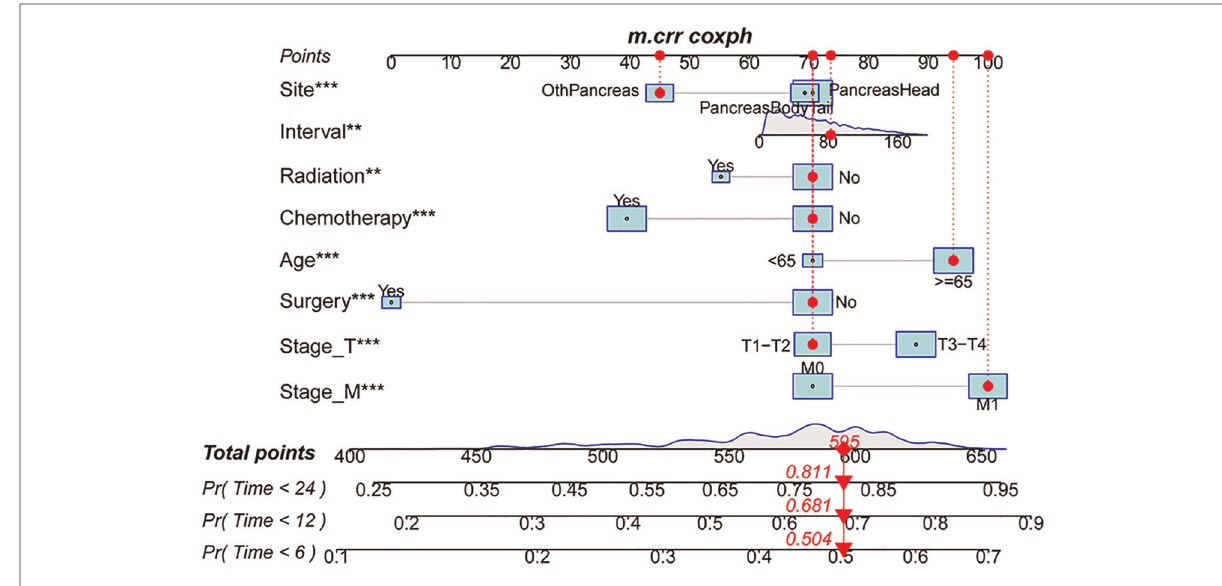
FIGURE 6 Nomogram for predicting 6-month, 1-year, and 2-year pancreatic ductal adenocarcinoma-speci fi c mortality in patients with second primary pancreatic ductal